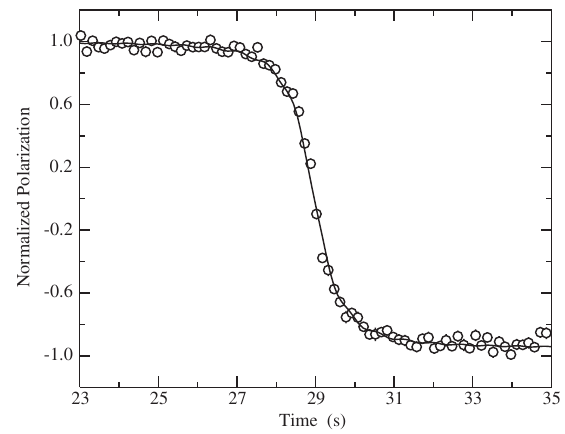
FIG. 8. Froissart-Stora scan across the 1 (cid:1) G(cid:1) resonance, which is close to the point where the polarization passes through zero. These data were measured with the uncooled beam. The curve is calculated assuming a resonance frequency of 871 434 Hz and a ramp rate of 40 Hz = s starting from 871 200 Hz at 5.8 s. Some tracks with large synchrotron ampli- tudes have been removed to achieve agreement with the final